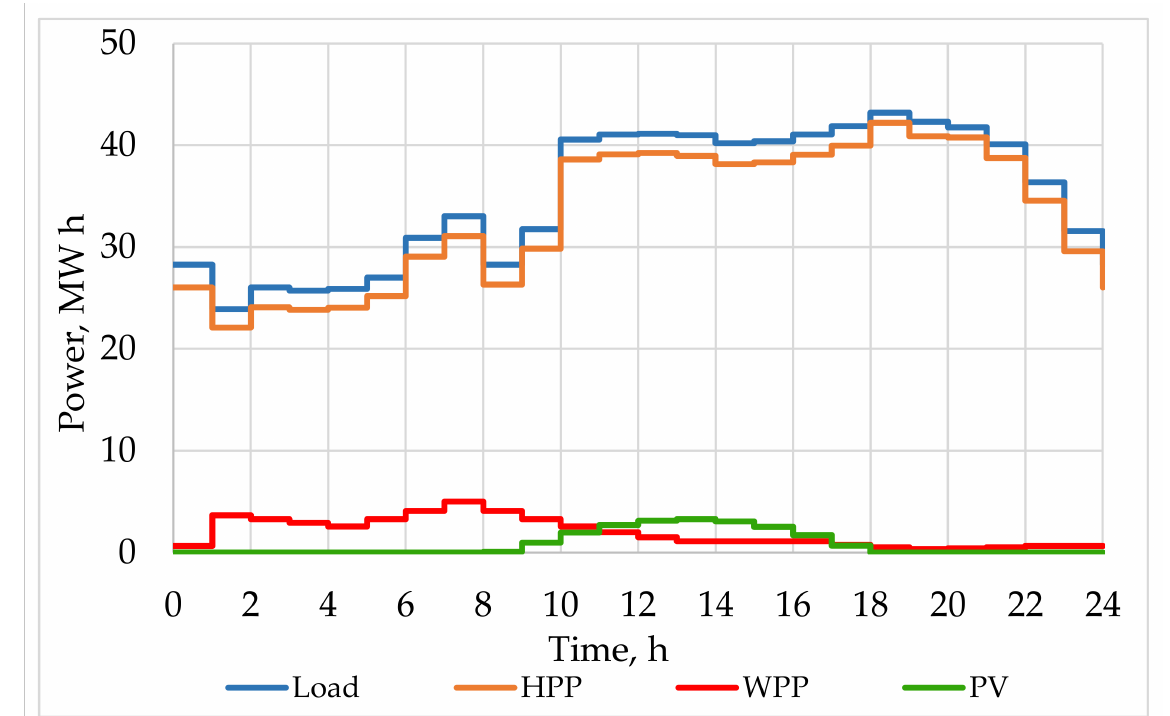
Figure 4. The initial information of the energy balance for a typical winter